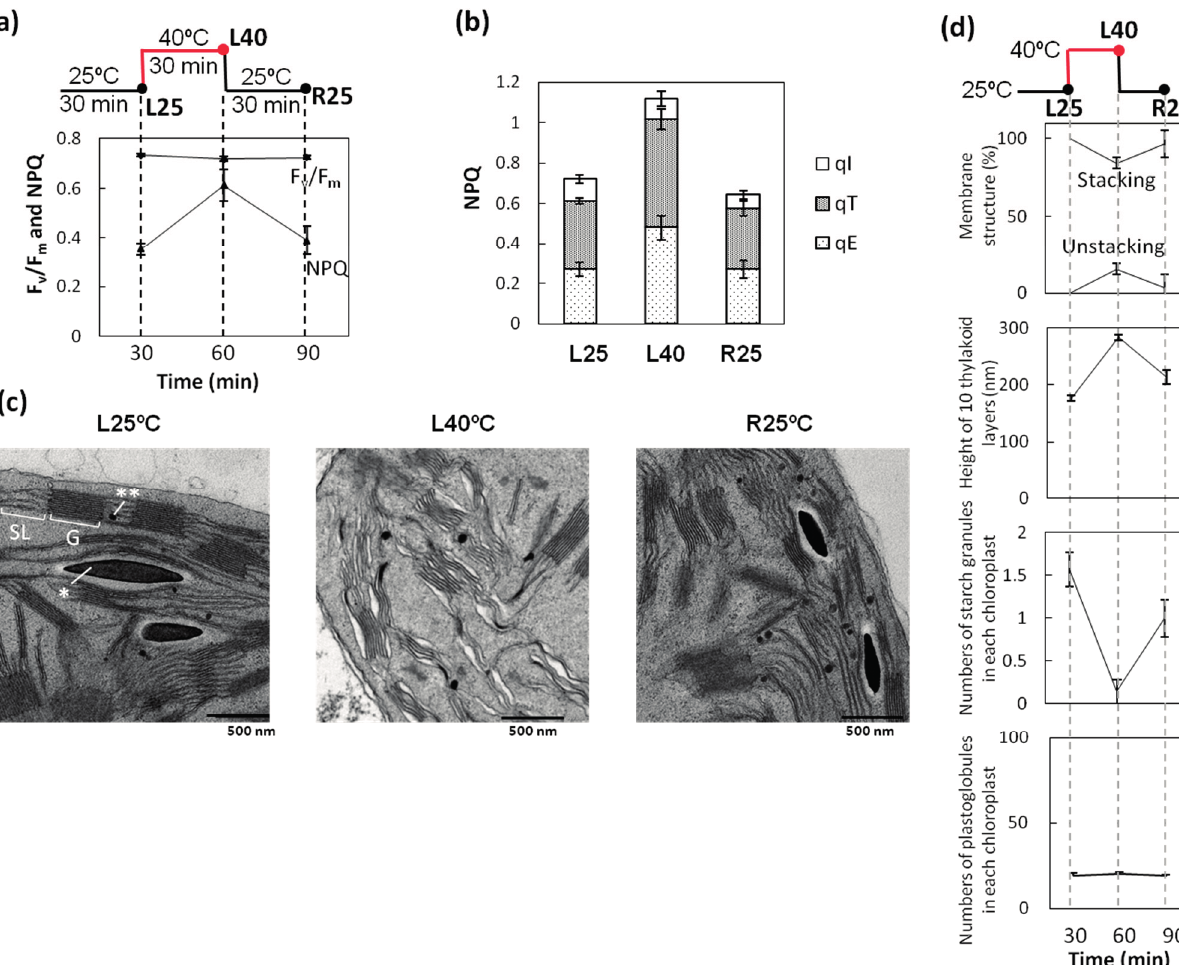
Figure 1. Heat treatment in light induced increase of NPQ (non-photochemical quenching) and unstacking of thylakoid membrane. ( a ) PSII (Photosystem II) maximum quantum efficiency ( F v / F m ). One-week-old wheat seedlings were heat-stressed under light (100 μ mol photons m − 2 ·s − 1 ; L40). L40 wheat recovered at 25 °C was used as R25. Non-heat-stressed wheat was used as the control L25 plant. Actinic light (AL), 190 µmol photons m − 2 ·s − 1 . Error bars indicate ± standard errors (SEs) ( n = 3); ( b ) Non-photochemical quenching (NPQ), qE, qT, and qI of each sample. AL, 820 µmol photons m − 2 ·s − 1 ; ( c ) Electron micrographs of wheat leaves: left panel, control plant; middle panel, plant heat-stressed in light (100 µmol photons m − 2 ·s − 1 ); right panel, plant recovered in light from heat stress at 25 °C. Single and double asterisks indicate a starch granule and a plastoglobule, respectively. SL, stroma lamellae. G, Grana. Bars = 500 nm; and ( d ) Graphs: top panel, percentage of stacked and unstacked isolated wheat thylakoid membranes. ( n = 3); Upper middle panel, height of 10 thylakoid layers (nm); Lower middle panel, starch granules in a chloroplast; bottom panel, numbers of plastoglobules in each chloroplast. Error bars indicate ± SEs ( n = 50). Note that L40 chloroplasts altered thylakoid membranes but not those of L25 and